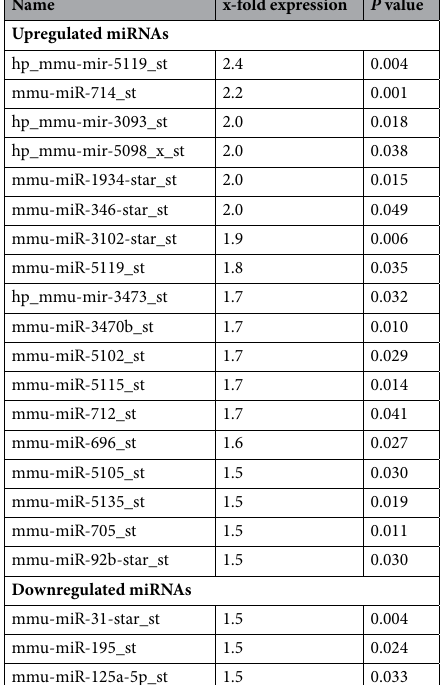
Table 2. Differentially expressed miRNA in Tax1BP1 −/−